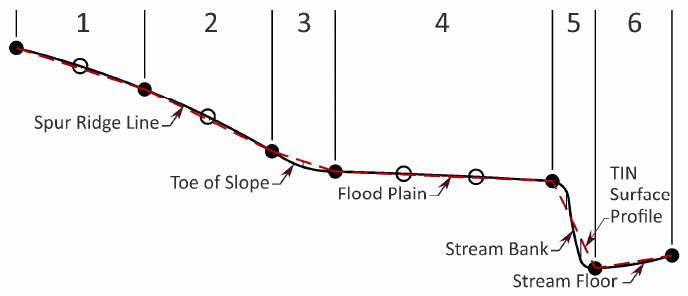
Figure 5. Simulated terrain profile including a spur, a floodplain, and a stream. Unlabeled circles represent Lidar sample points projected to the profile. Unfilled dots are eliminated points. Filled dots are retained points.